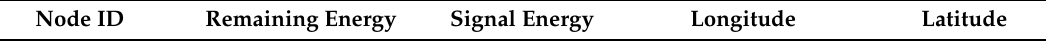
Table 3. DF information format.